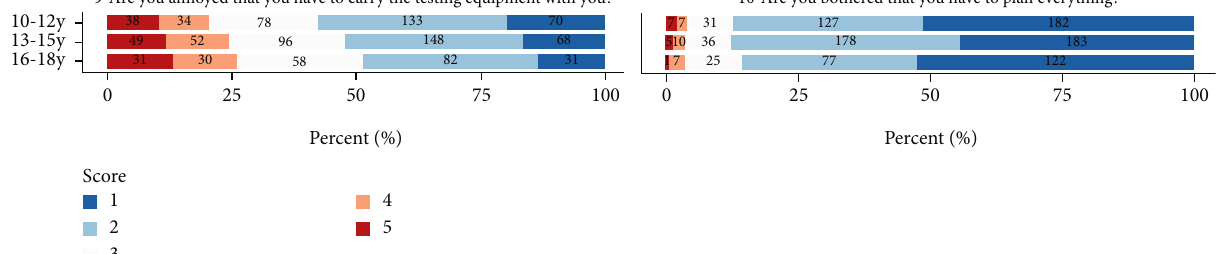
( B = − 4 : 60 (95% CI for B = − 6 : 84 , -2.36), p < 0 : 001 ) and treatment ( B = − 8 : 02 (95% CI for B = − 10 : 9 0, -5.13), p <